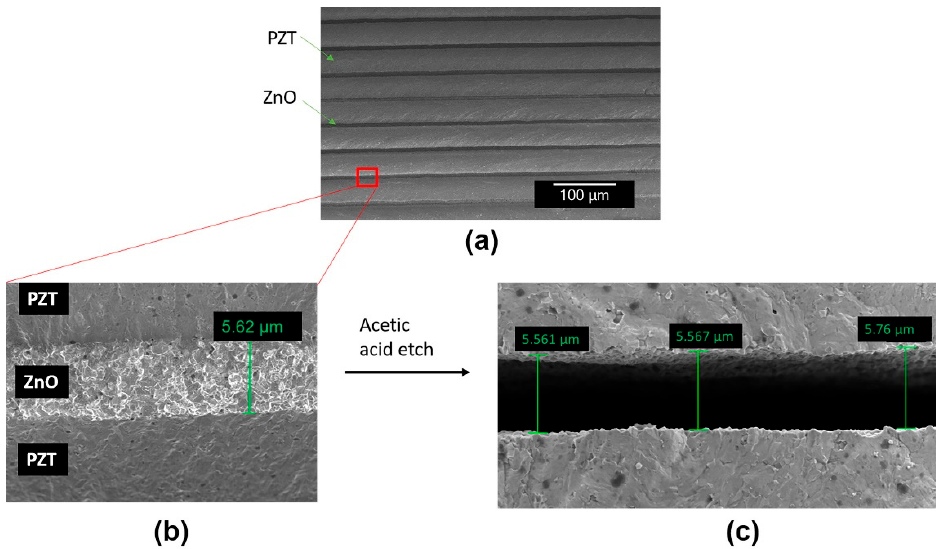
Figure 5. Cross section of a 16 element PZT–ZnO 3-0 composite after the post anneal step, demonstrating uniformity in thickness along the length of the composite showing: ( a ) the multiple layers of PZT and ZnO; ( b , c ) magnified microstructure of the composite showing the thickness of the ZnO layer ( b ) before and ( c ) after etching with acetic acid. The surface roughness of the kerf region is on a submicron length scale, which is expected to be reasonable for high frequency 2-2 composites. Table 3. A 17 μ m ZnO green tape cast sheet reduced to 5.4 μ m upon densification in the sample with 32 elements. This corresponds to a ~68% shrinkage in each of the ZnO layers. Thus, to reach the desired thickness of ~34 μ m, PZT tapes were stacked to ~112 μ m thick-